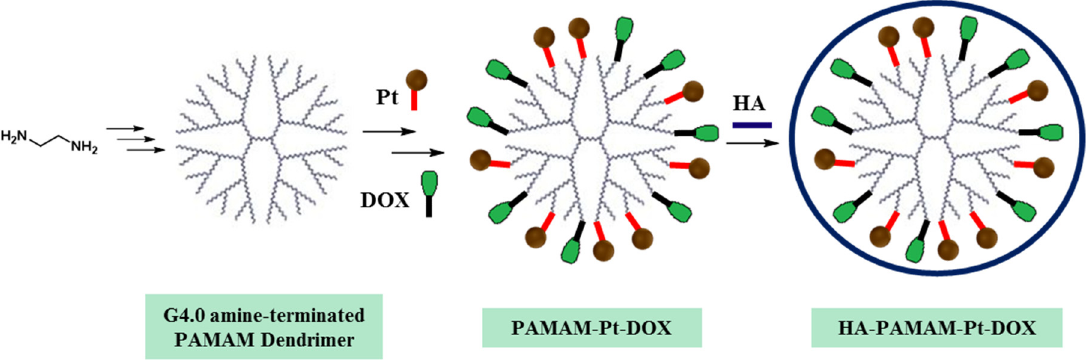
Figure 7. Scheme of the synthesis of PAMAM dendrimers with two drugs (Pt and DOX) covalently linked to the amine groups of the outer generation of the dendrimer. The addition of an external shell of HA, which is coordinated through electrostatic interactions with PAMAM, improve the biocompatibility of the dendrimers.